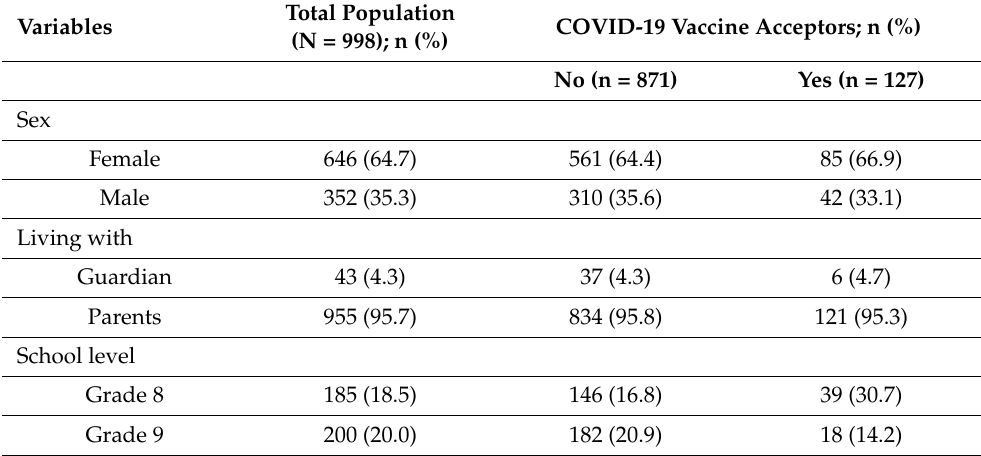
Table 1. Socio-demographics, knowledge and attitude scores by vaccine